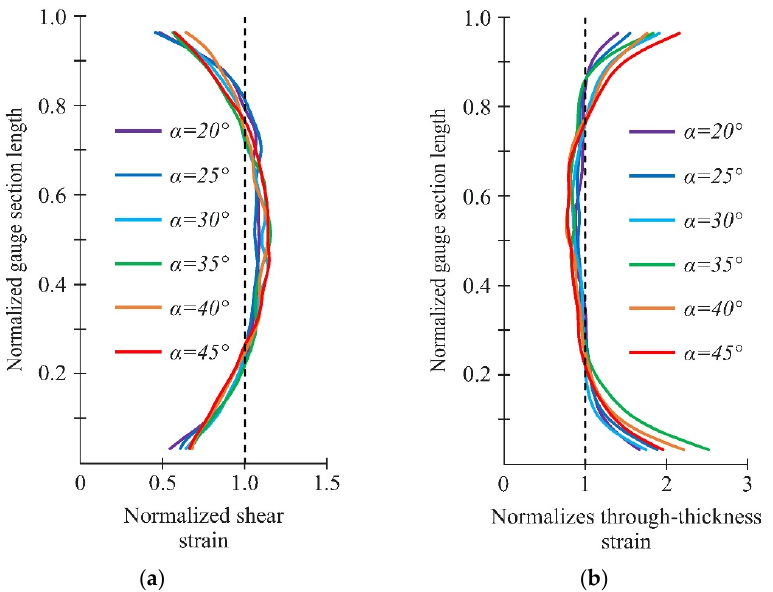
Figure 13. Distribution of shear strain at maximum load: ( a ) on the face surface at α = 20°, ( b ) on the face surface at α = 45°, ( c ) between the notches.